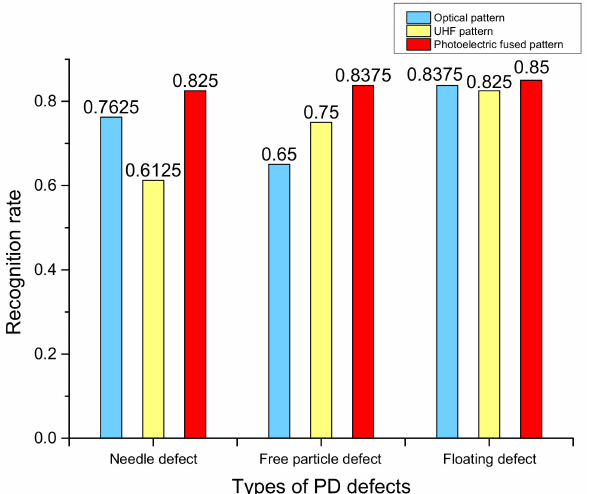
Figure 17. Average recognition rate of each defect under di ff erent kinds of patterns (with 120 training